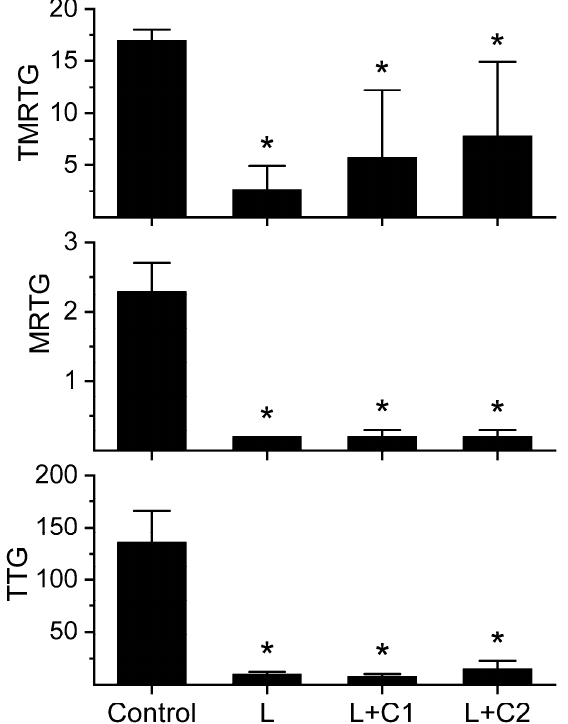
Figure 3. The kinetomic effects of exposure of the LAAO to CORM-2. The data are displayed as the mean ± SD. TMRTG = minutes; MRTG = dynes/cm 2 /sec; TTG = dynes/cm 2 . Control = plasma without LAAO addition; L = plasma with additive naive 500 nM LAAO addition; L + C1 = LAAO exposed to 100 µM CORM-2 prior to addition to plasma; L + C2 = LAAO exposed to 1 mM CORM-2 prior to addition to plasma. * p < 0.05 versus Control.